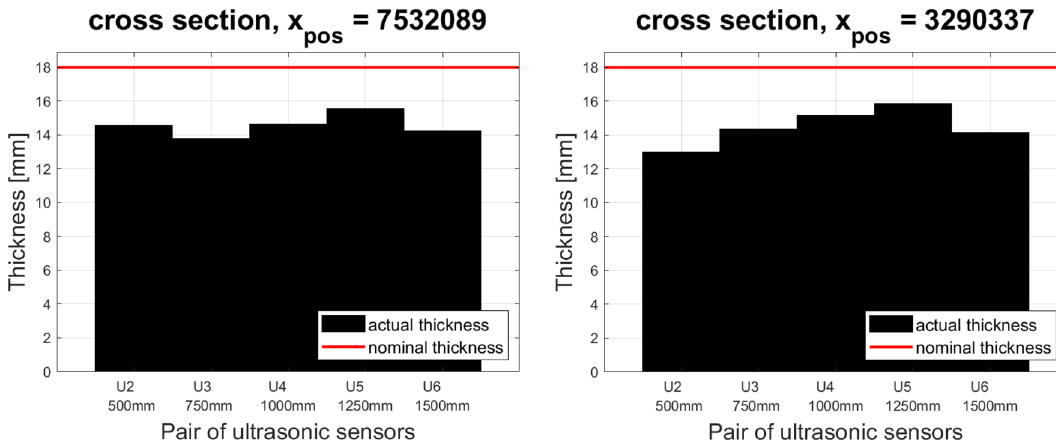
Figure 5. The cross-section of the conveyor belt—device prototype testing.